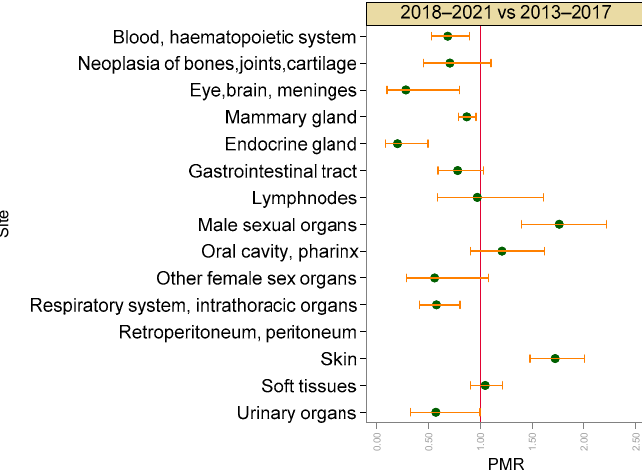
Figure 7. Proportional morbidity ratios (PMR) of malignant tumours by topography comparing the last years of activity (2018–2021) with the first period of activity (2013–2017). Dots: age-class-adjusted PMRs, bars: lower and upper bound of 95% confidence interval. A vertical reference line indicates PMR = 1.